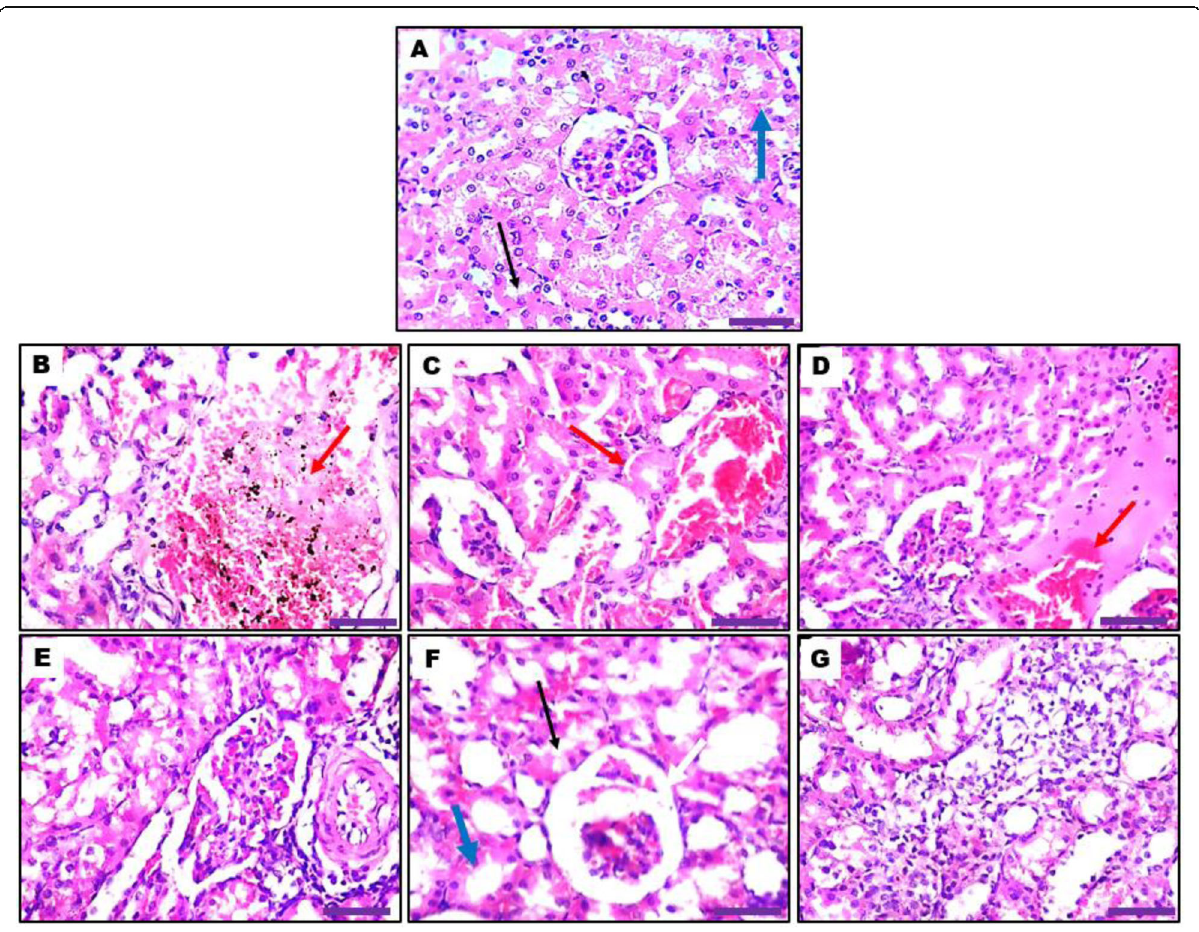
Fig. 6 ( a - g ): Photomicrographs of renal micromorphological sections of STZ-induced diabetes rats treated with petroleum and diethyl ether fractions of B. ferruginea Benth leaves. ( a ) Normal control ( b ) STZ-induced animals administered 2 ml/kg b.w. of Normal saline ( c ) STZ-induced animals treated with 5 mg/kg b.w. of metformin ( d ) STZ-induced animals treated with 100 mg/kg b.w. of petroleum ether fraction of B. ferruginea ( e ) STZ-induced animals treated with 200 mg/kg b.w. of petroleum ether fraction of B. ferruginea ( f ) STZ-induced animals treated with 100